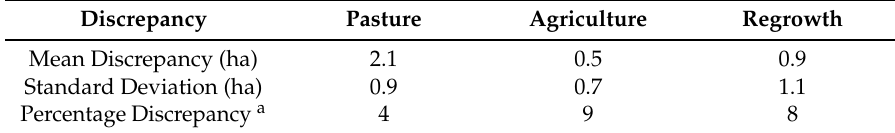
Table 1. Discrepancies between self-reported and measured areas of Household Agricultural Land Uses. Discrepancy Pasture